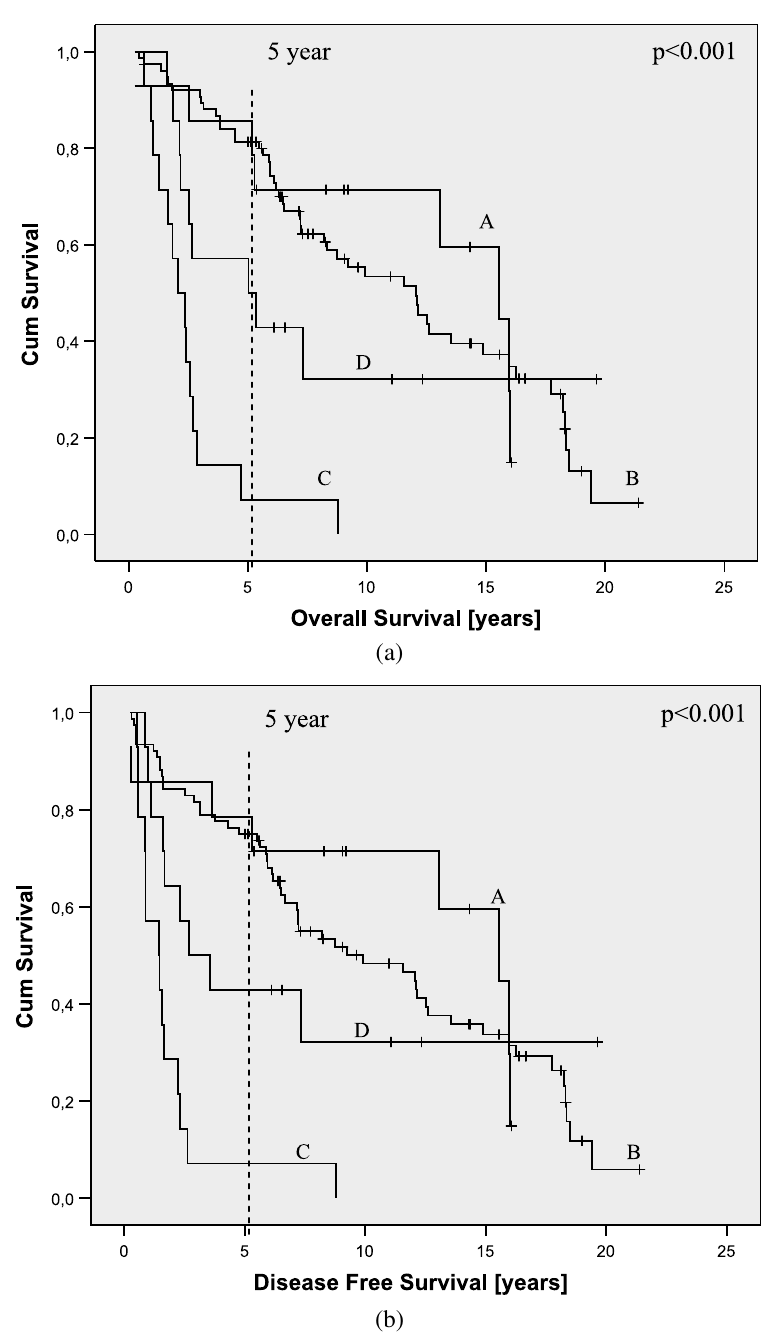
Fig. 2. Kaplan–Meier survival curves for stroma-high patients and stroma-low patients with positive and negative SMAD4 staining: (a) OS, (b) DFS. Notably, the mean age of the analyzed patient group was 68.2 years with a mean follow-up time of 10.9 years. As some patients have a follow-up period of 20 years the full survival time was displayed. A. Stroma-low/SMAD4-negative; B. Stroma-low/SMAD4-positive; C. Stroma-high/SMAD4-negative; D. Stroma-high/SMAD4-positive. with specific bad prognosis. When confirmed in series to a better selection of high-risk stage I and II pa- from other institutions our approach might contribute tients that might benefit from adjuvant treatment.